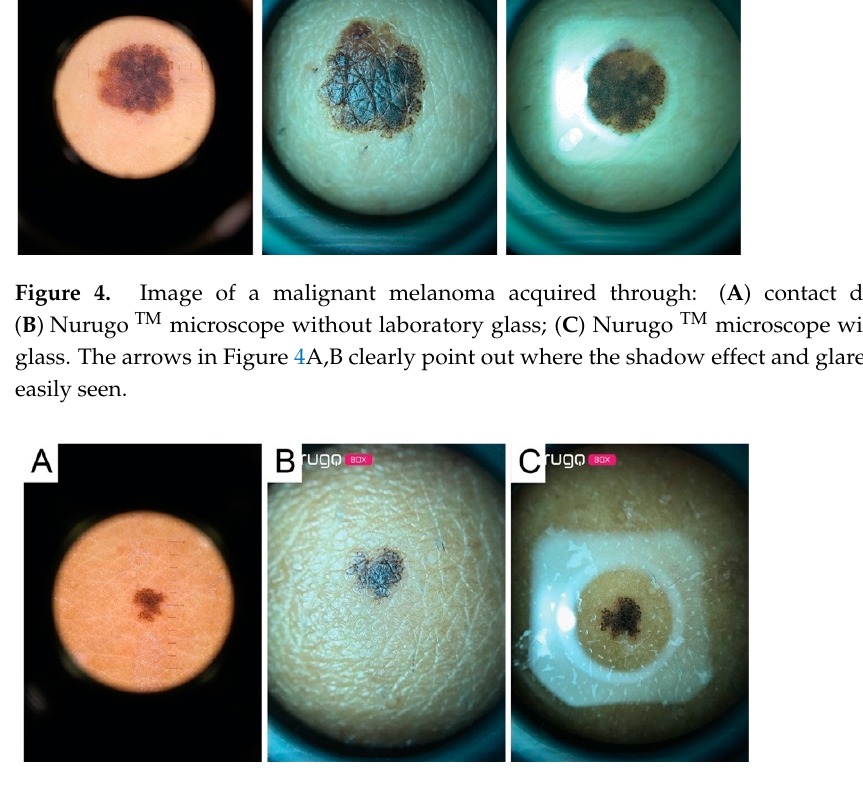
Figure 5. Image of a melanocytic nevus acquired through: ( A ) contact dermatoscope; ( B ) Nurugo TM microscope without laboratory glass; ( C ) Nurugo TM microscope with laboratory glass.